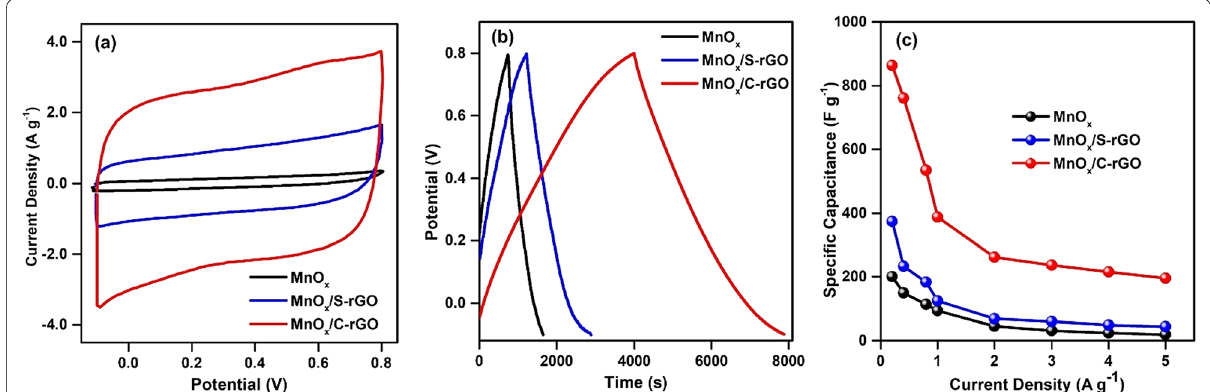
Fig. 3 Three-electrode system measurements: a CV curves at a scan rate of 50 mV s − 1 ; b GCD curves at a current density of 0.2 Ag − 1 , and c specific capacitances at different current densities for MnO x , MnO x /S-rGO, and MnO x /C-rGO electrodes